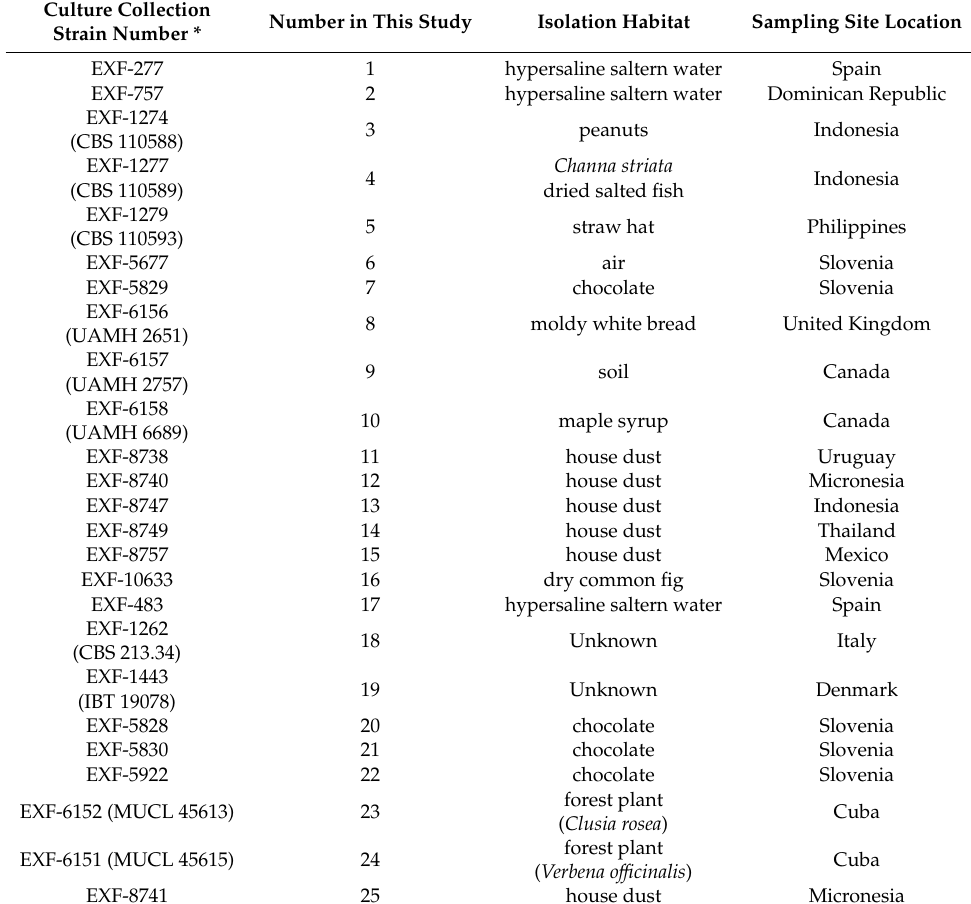
Table 1. Strains sequenced in this